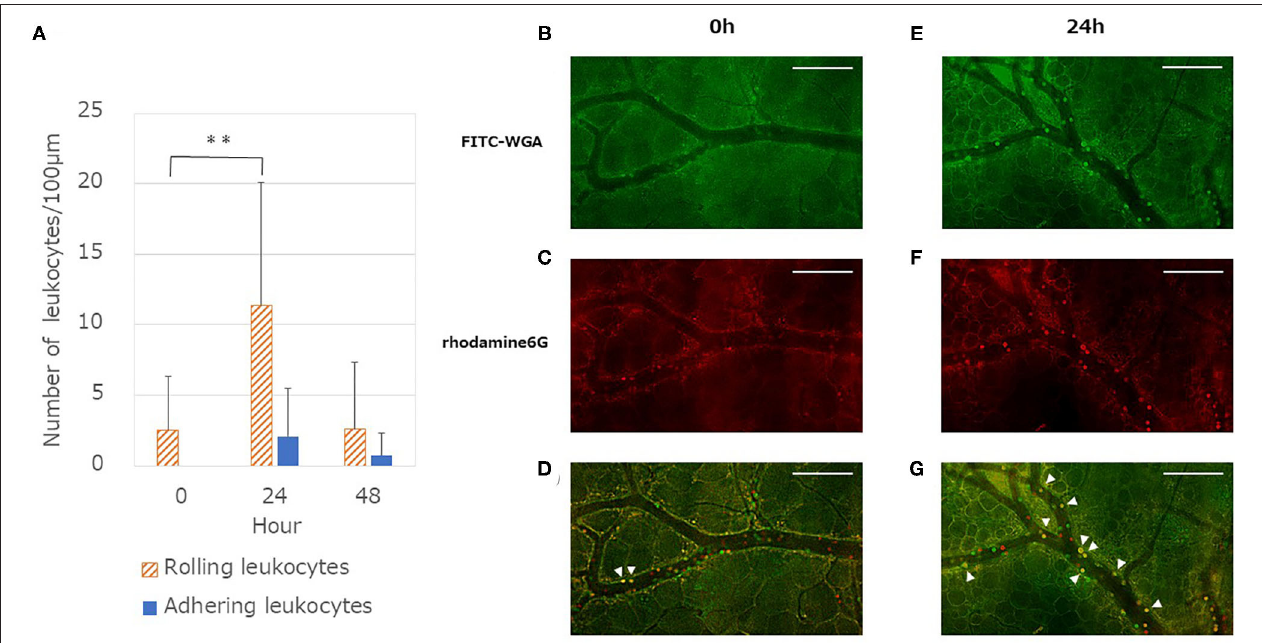
FIGURE 3 | Quantitative analysis of leukocytes endothelium interactions after LPS administration. (A) Number of rolling leukocytes increased at 24h and showed a significant difference compared with the values at 0h [One-way ANOVA followed by Dunnett’s test (** P < 0.01)]. By contrast, there is a small difference in the number of adhering leukocytes but this is not significant in the one-way ANOVA ( P = 0.10). Each column represents the mean ± SD of 12 measurements from four mice at each time point. (B,E) Typical merged images of anesthetized mouse dorsal skin microvasculature: glycocalyx and leukocytes stained using FITC-WGA (green). (C,F) Typical merged images of microvasculature: cells containing mitochondria (leukocytes and platelets) stained using rhodamine 6G (red). Images in (C,F) captured 8s after images in (B,E) . (D) Merged image of (B,C) captured at 0h. (G) Merged image of (E,F) captured 24h after LPS administration. Yellow cells (arrowheads) represent leukocytes that adhered to the endothelium. By contrast, red or green cells represent rolling leukocytes with weak interaction with the endothelium. Images modified (colored and merged) using commercial software. Scale bar: 100 µ m.